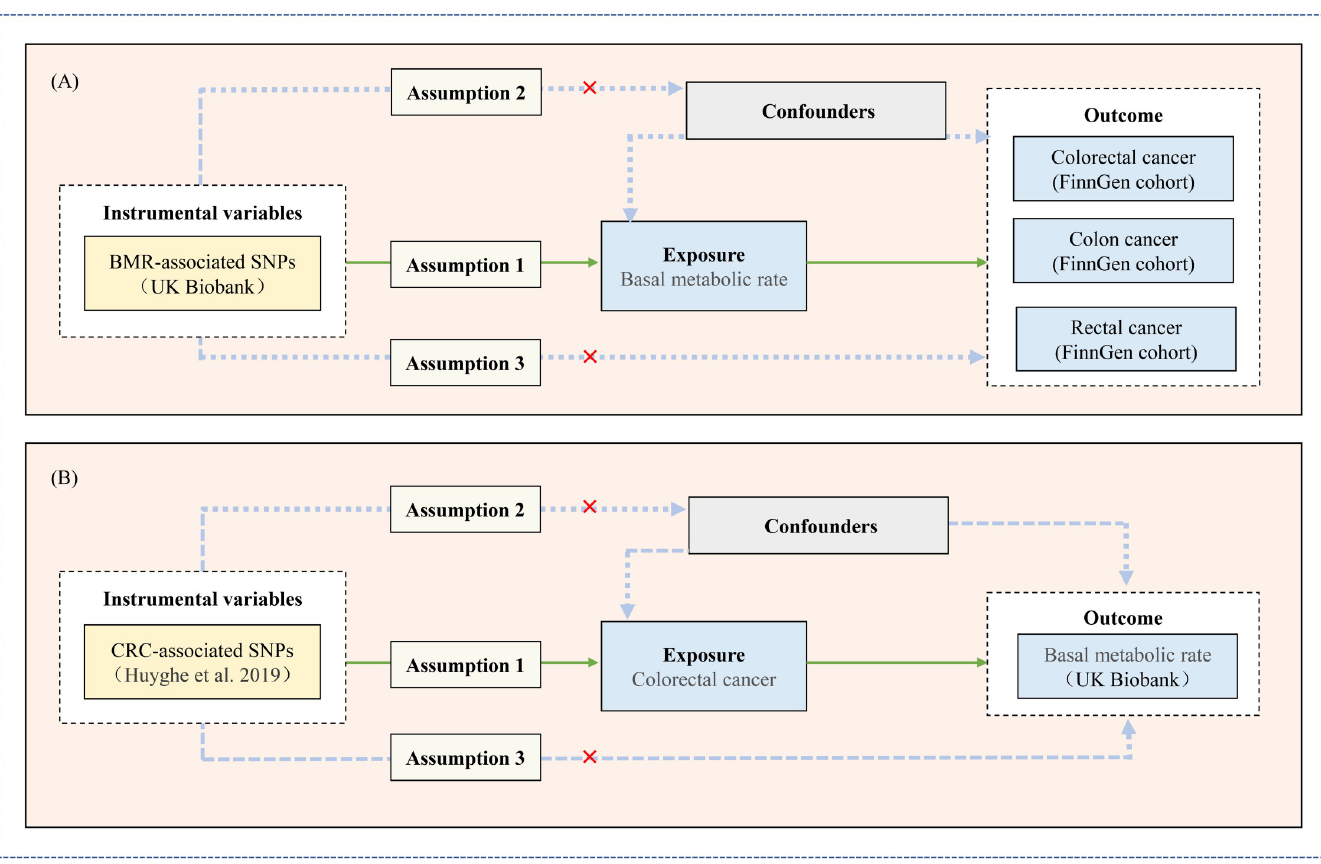
Fig 1. Schematic diagram of the Mendelian randomization assumptions. (A) MR analysis of the association between BMR and CRC or colon cancer or rectal cancer risk; (B) MR analysis of the association between CRC and BMR risk; Abbreviation: BRM, Basal metabolic rate; CRC, colorectal cancer; SNP, single-nucleotide